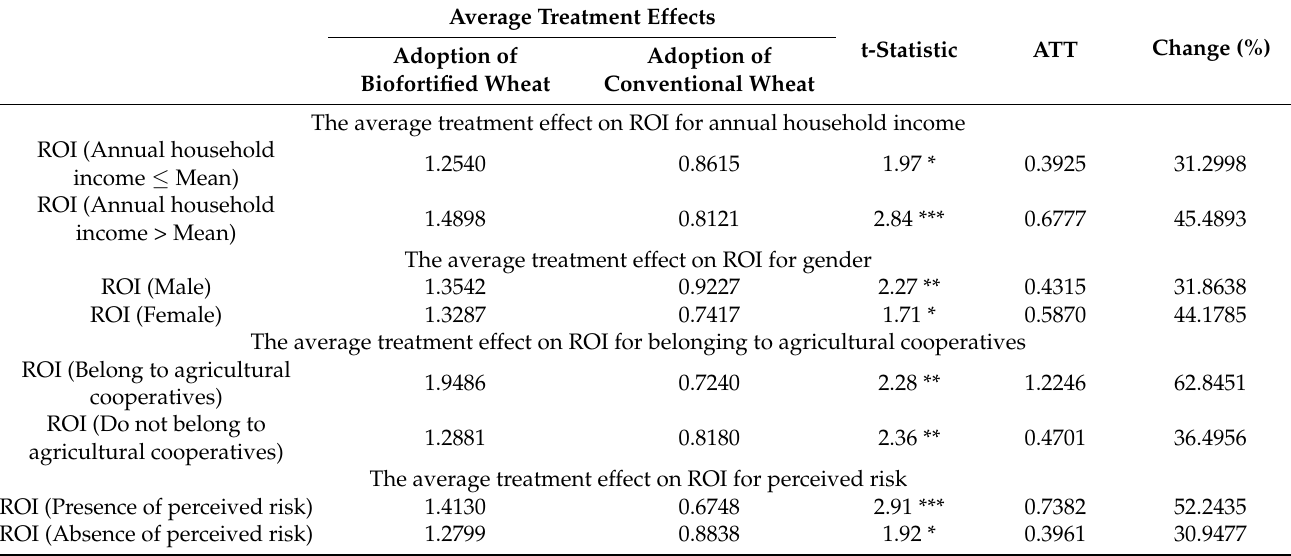
Table 7. The average treatment effects of the adoption of wheat biofortification on ROI. Average Treatment